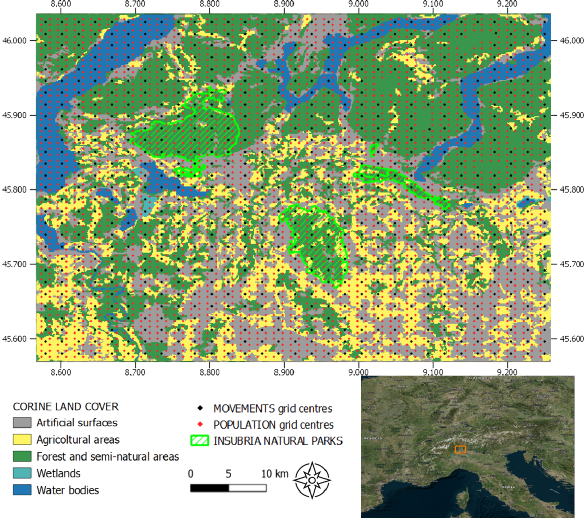
Figure 1. The Insubria region (Coordinate Reference System: WGS84) with the CLC classes and natural park areas highlighted. Black and red spots represent centroids of the Facebook data grids respectively for the users’ movements and population datasets. (Basemap: Bing Satellite ©